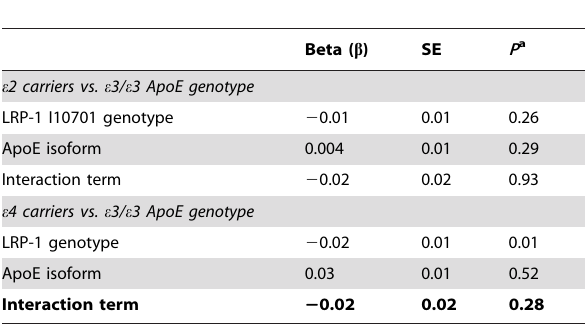
Table 4. Parameter estimates from linear regression